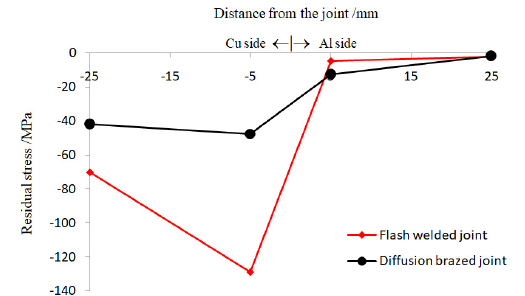
Figure 13. Residual stress across the Cu/Al